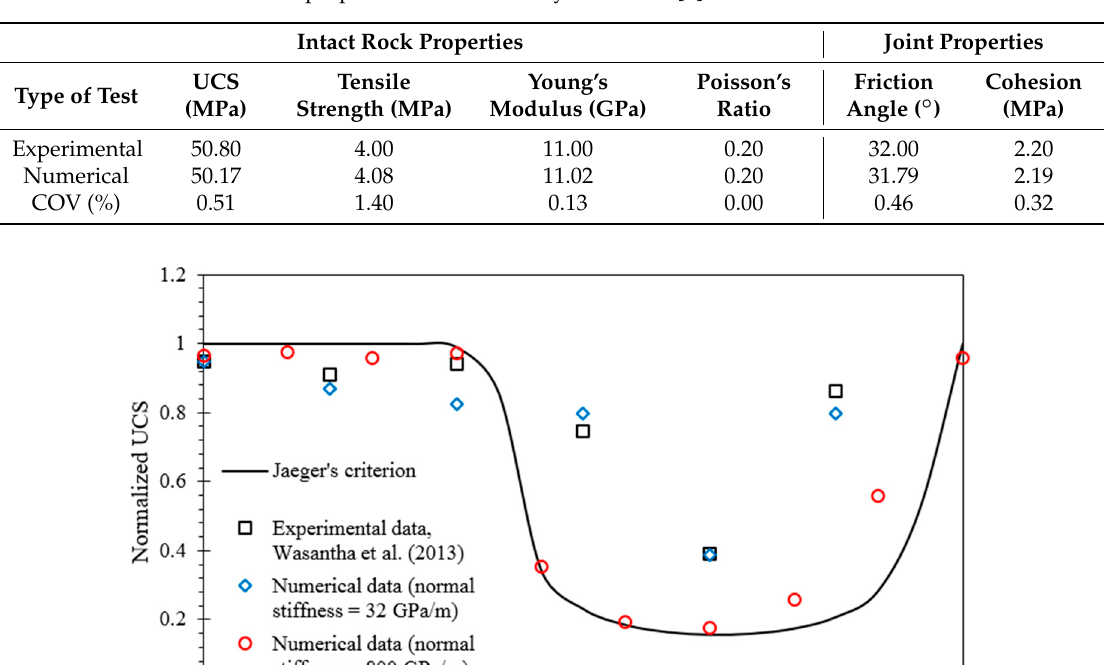
Table 2. Mechanical properties of Hawkesbury sandstone [8] and calibrated BPM material.